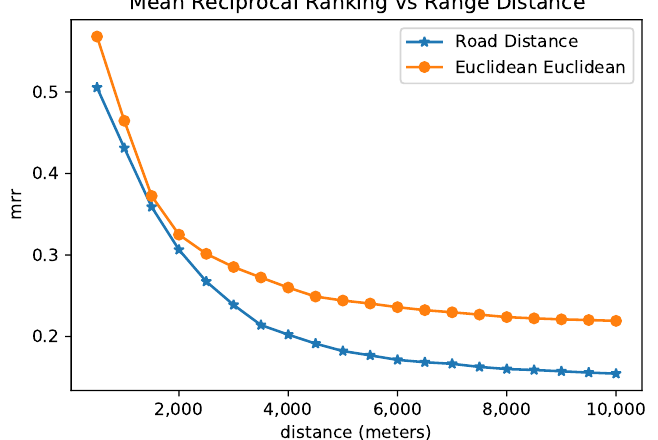
Figure 8. Mean reciprocal rank of embeddings among sensors inside a neighborhood in